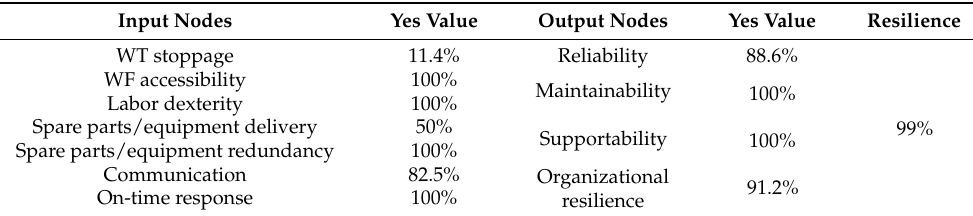
Table 2. Summary of baseline scenario input and output nodes.